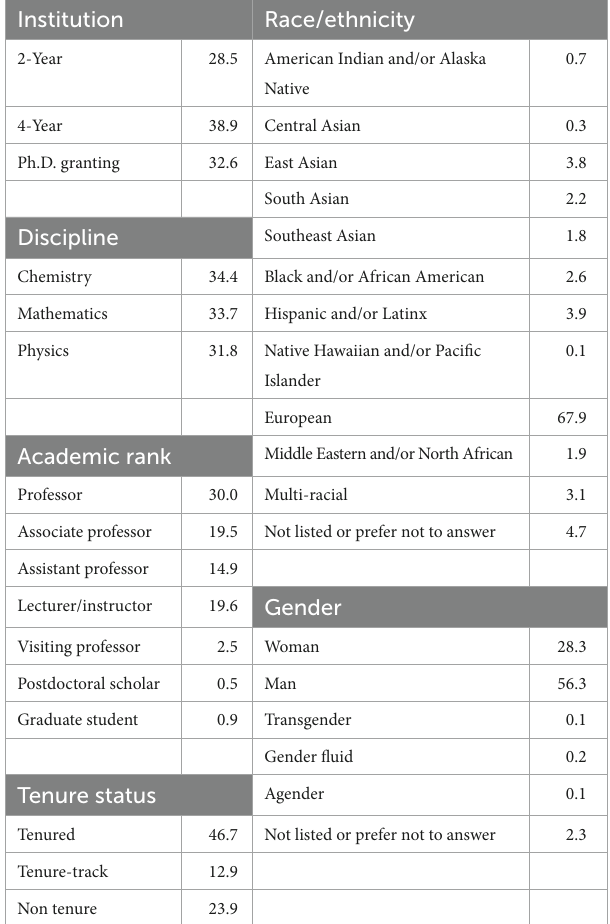
TABLE 1 Demographics of survey respondents. TABLE 2 Demographics of interview participants ( n = 24). Numbers represent participants having each